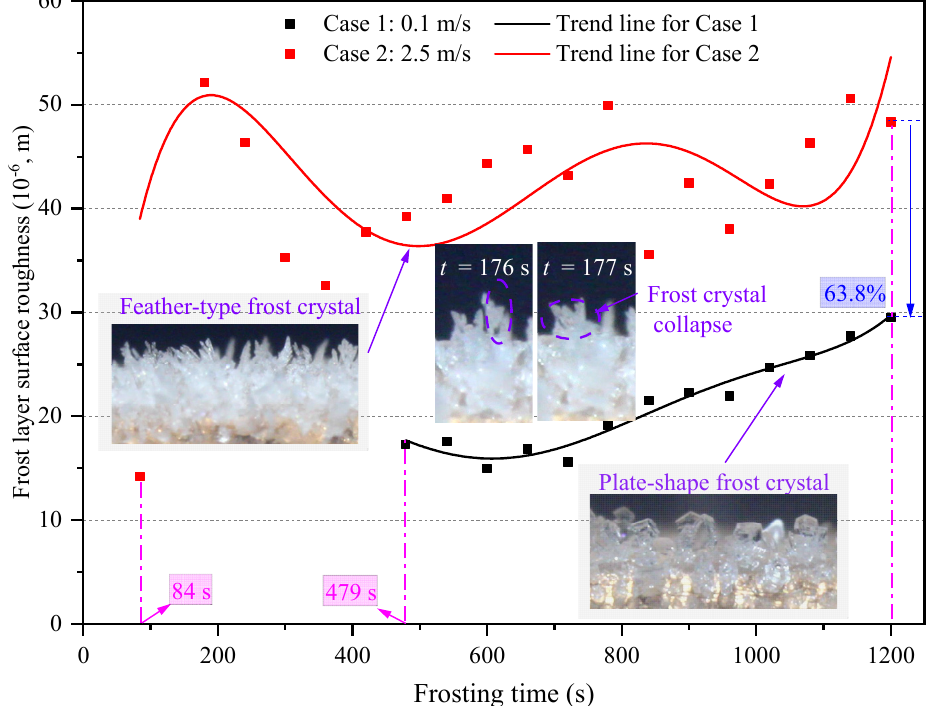
Figure 14. Frost layer surface roughness in the edge-affected